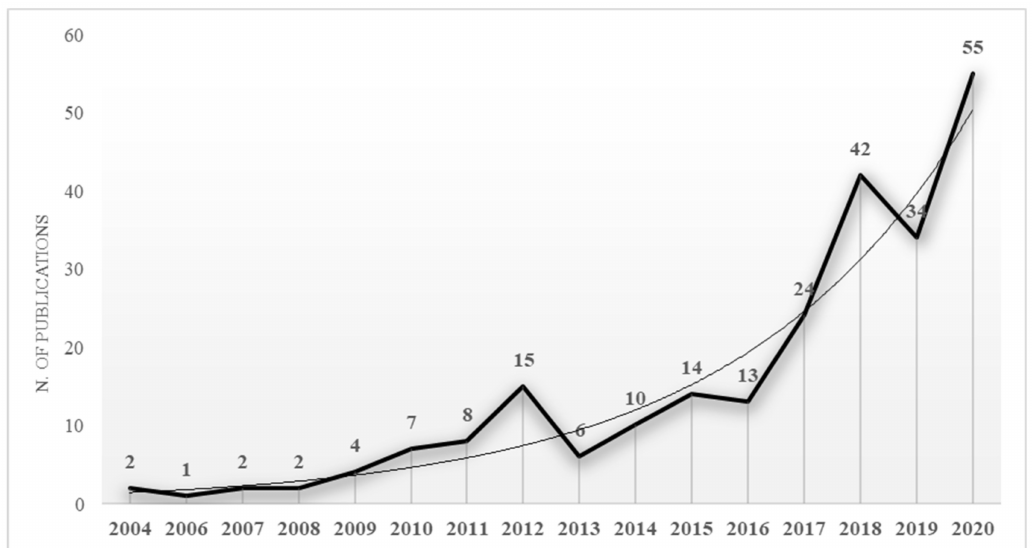
Figure 2. Evaluation of the number of scientific publications per